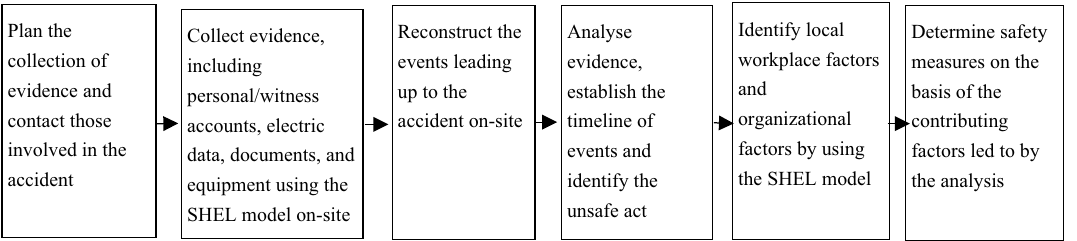
Figure 1. Flow chart on how an accident should be investigated. Adapted from Ref. 30 , International Maritime